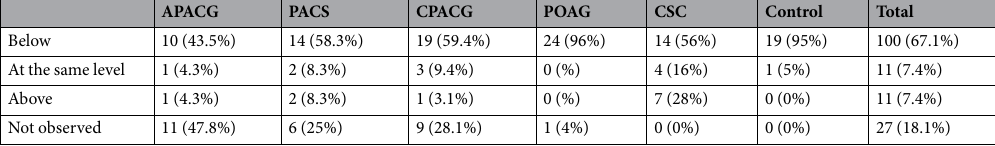
Table 3. Rate of linear artifact line above, below or at the same level as the sclerochoroidal